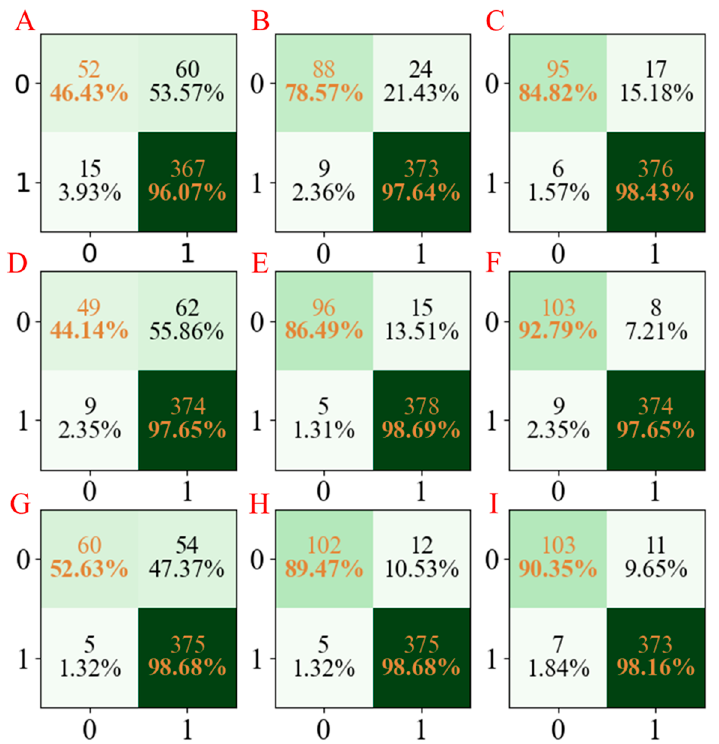
Figure 7. The confusion matrix of three models established for MN characteristics. The confusion matrix of the PLS-DA model using seed numbers1234 ( A ), 5678 ( D ), and 1278 ( G ); the confusion matrix of the AdaBoost model using seed numbers 1234 ( B ), 5678 ( E ), and 1278 ( H ); the confusion matrix of the LGBM model using seed numbers 1234 ( C ), 5678 ( F ), and 1278 ( I ). Table 5. The precision, recall, and F1-score values of the established models for MN properties.